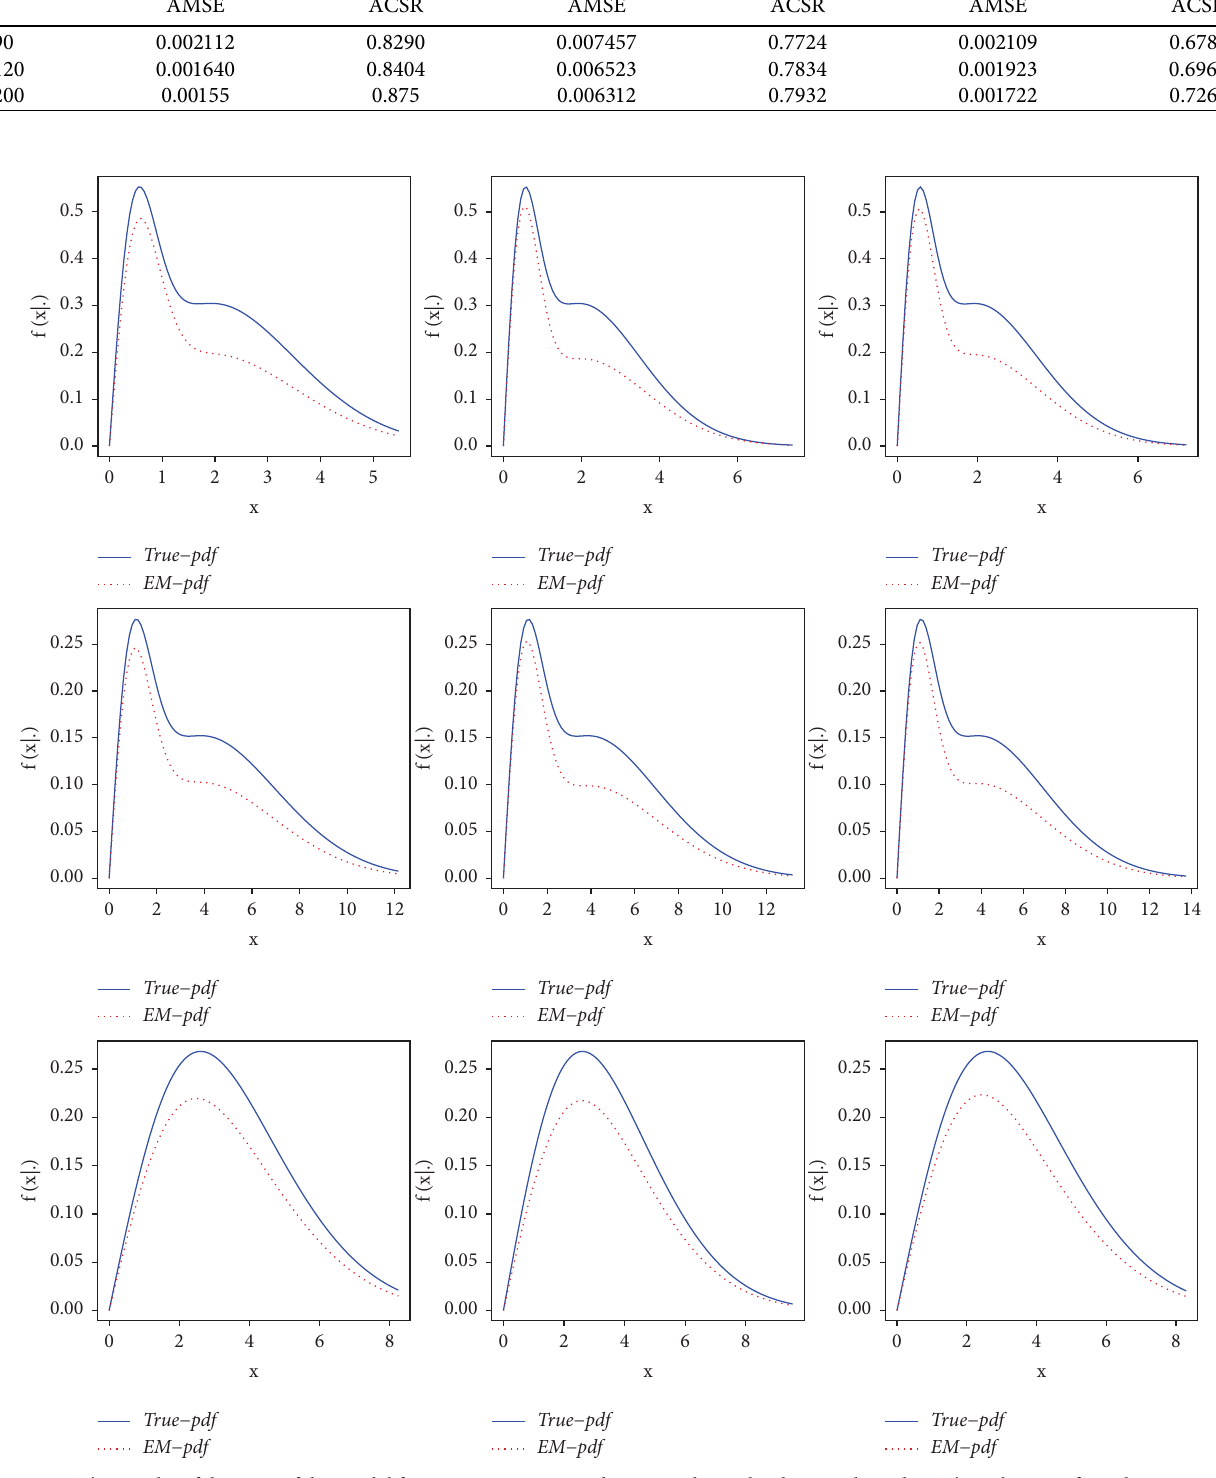
Table 1: Te results of AMSE and ACSR of applying the EM algorithm to simulated data from the two-component mixture model for three diferent scenarios and three diferent sample sizes with 1000 replications. � 0 . 35 , π � 0 . π 1 2 N